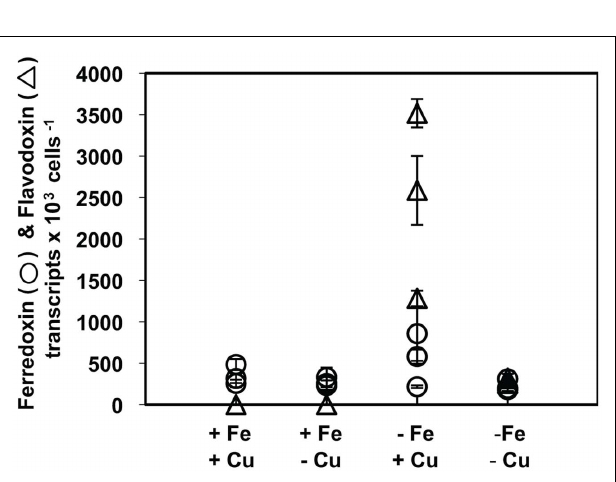
FIGURE 4 | (A) Ferredoxin and (B) flavodoxin transcript abundances normalized to cell number in T. pseudonana semi-continuous batch cultures grown in replete media under a 12:12h light:dark cycle and shifted into